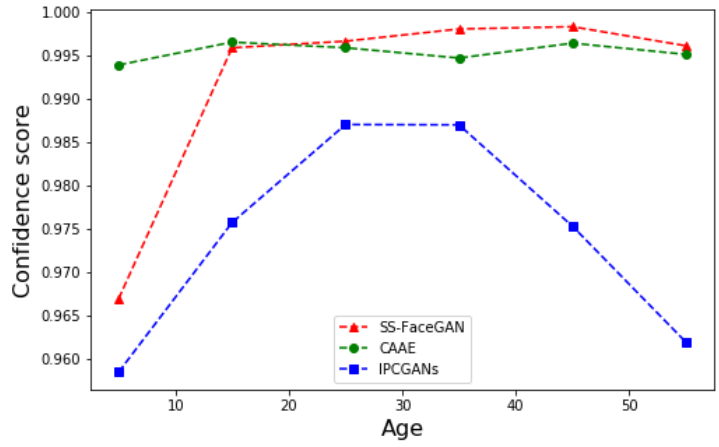
Figure 8. The performance on face recognition.